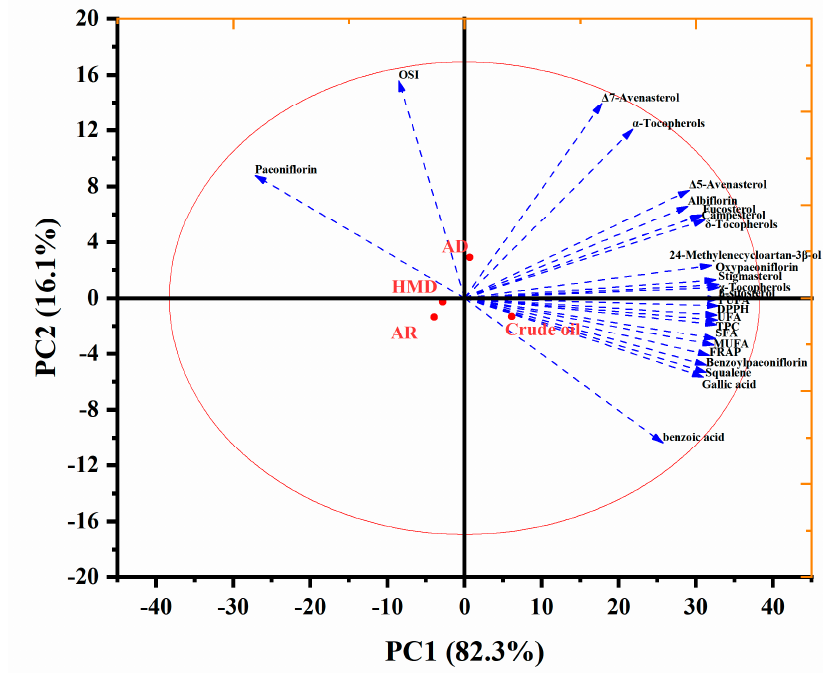
Figure 5. PCA of nutrient components in peony seed oil by deacidification.